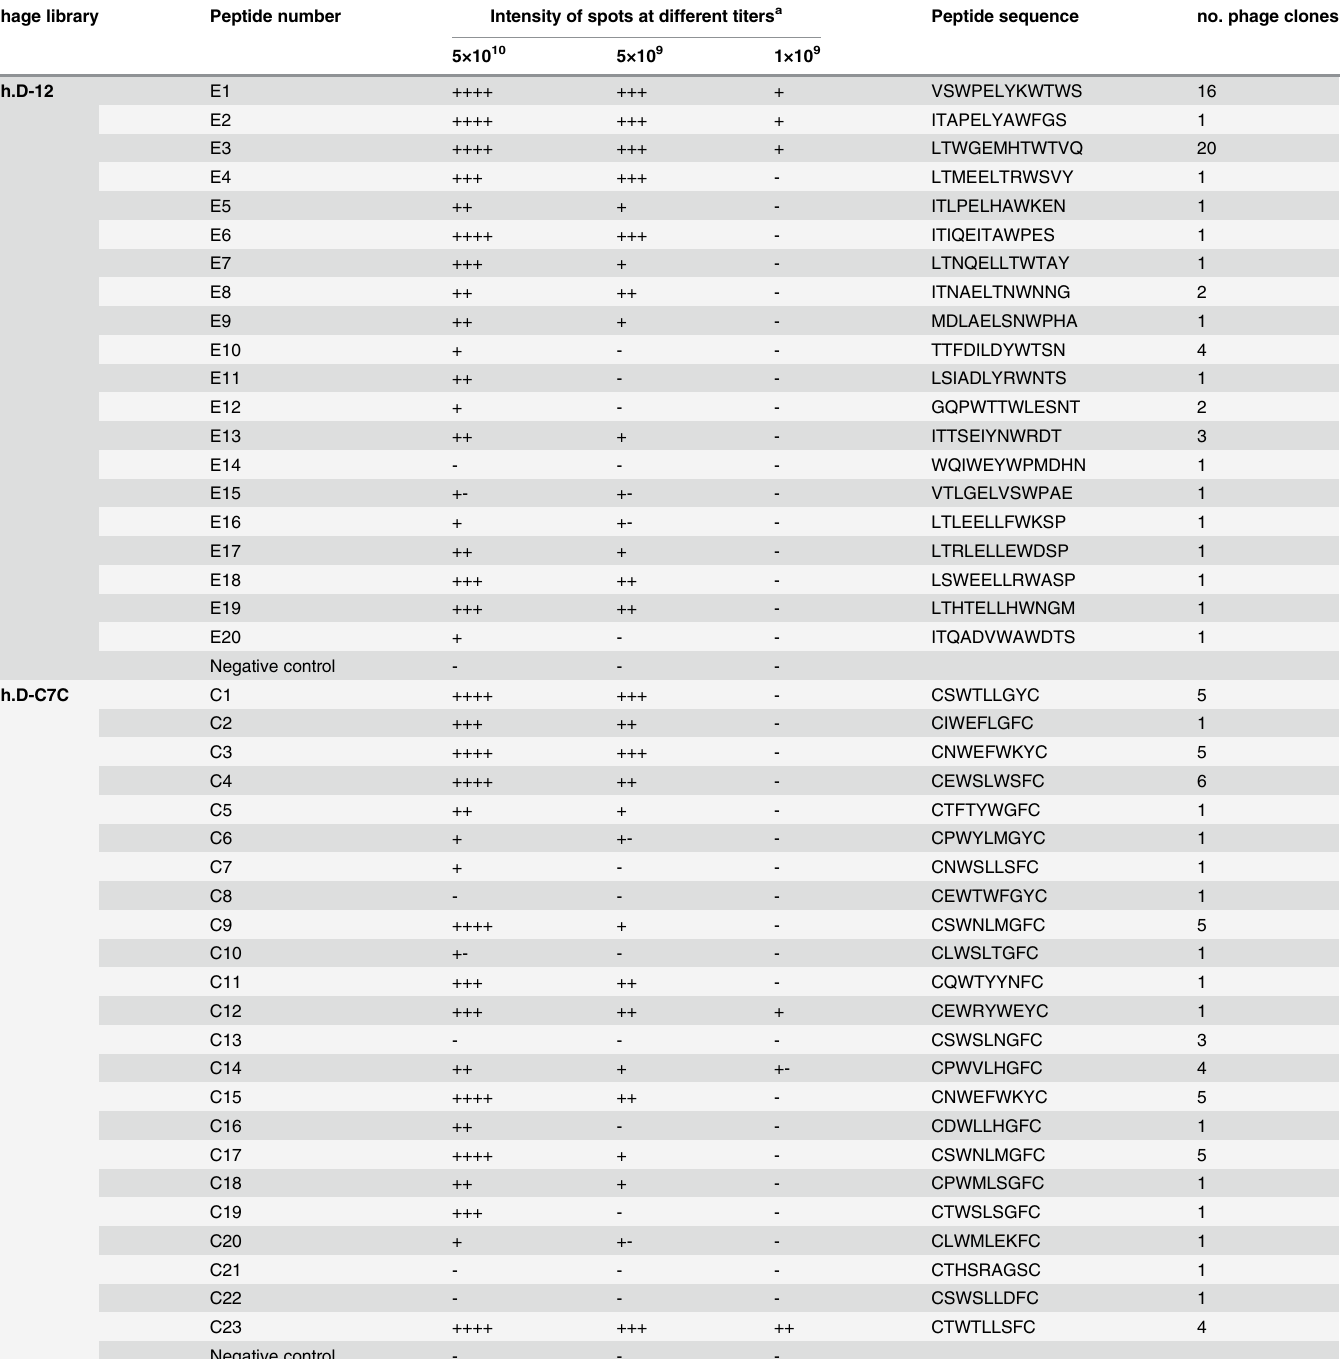
Table 1. Identi fi cation of 12-mer and cyclic 7-mer peptides that bind to bNAb VRC01 by panning Ph.D-12 and Ph.D-C7C phage peptide libraries. Phage library